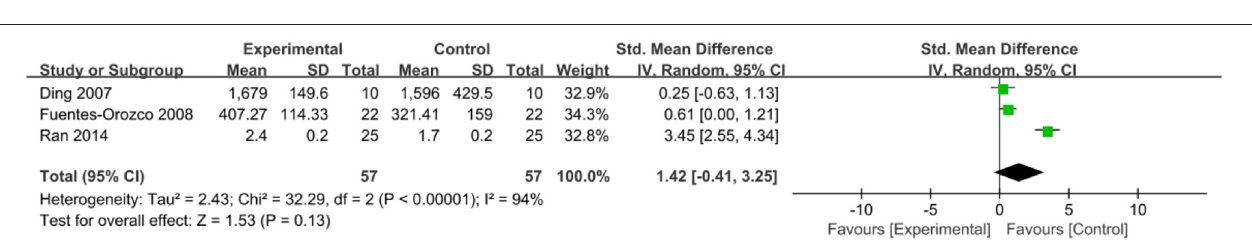
FIGURE 20 | Forest plots of IgA associated with experimental group (parenteral or enteral nutrition group supplemented with Gln) vs. control group (conventional nutrition group). I 2 tests and P are the criteria for the heterogeneity test, (cid:7) , pooled standard mean difference; — (cid:4) —, standard mean difference, and the edges of (cid:7)